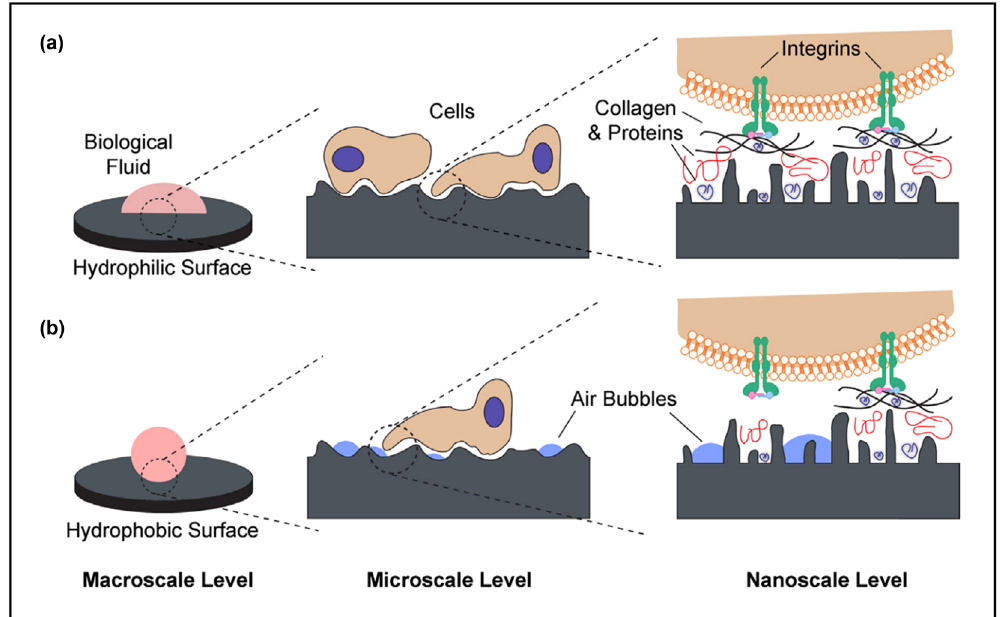
Figure 25: Schematic illustration of possible interactions at three levels of a ( a ) hydrophilic and ( b ) hydrophobic surface. ( a ) Hydrophilic surface allows direct interaction with biological fl uids and subsequent cell membrane receptors. ( b ) Hydrophobic surface is prone to hydrocarbon contamination that results in the entrapment of air bubbles and interference with the biological environment [ 356 ] . Copyright 2014, Elsevier ™